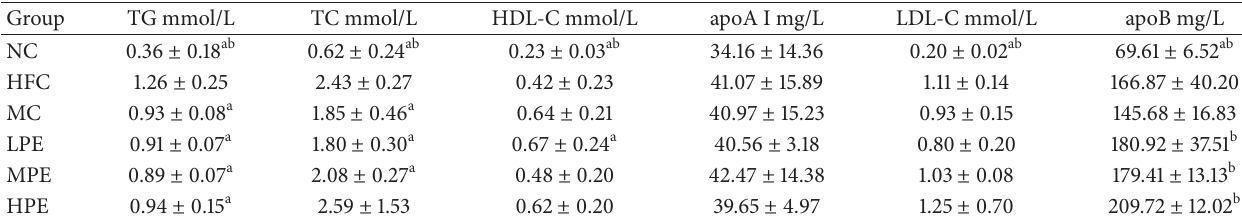
Table 2: Serum lipid and apolipoprotein levels of the experimental rats [ 𝑛 = 10 ].